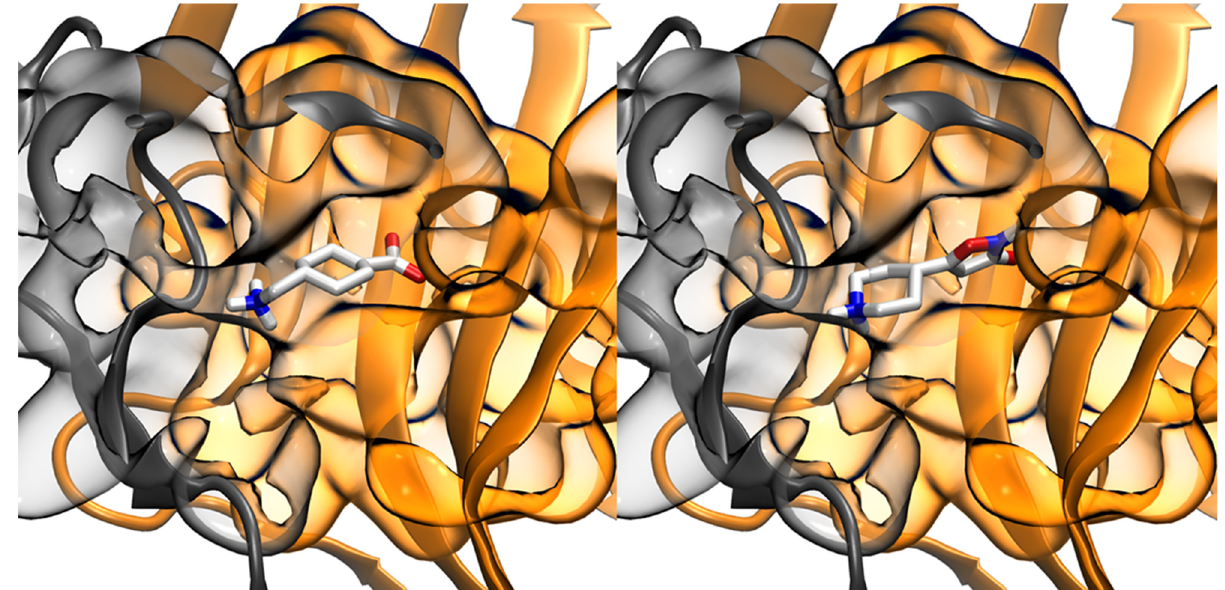
Figure 8. Representation of the most important distances for molecular dynamics simulations of compounds 1 and 9 . Distances for compound 1 : ( a ) piperidine and Asp57, ( b ) triazole (nitrogen N2) and Tyr72, ( c ) triazole (nitrogen N3) and Tyr72. Distances for compound 9 : ( d ) piperidine and Asp57, ( e ) triazole (nitrogen N2) and Tyr72, ( f ) triazole (nitrogen N4) and Tyr72.